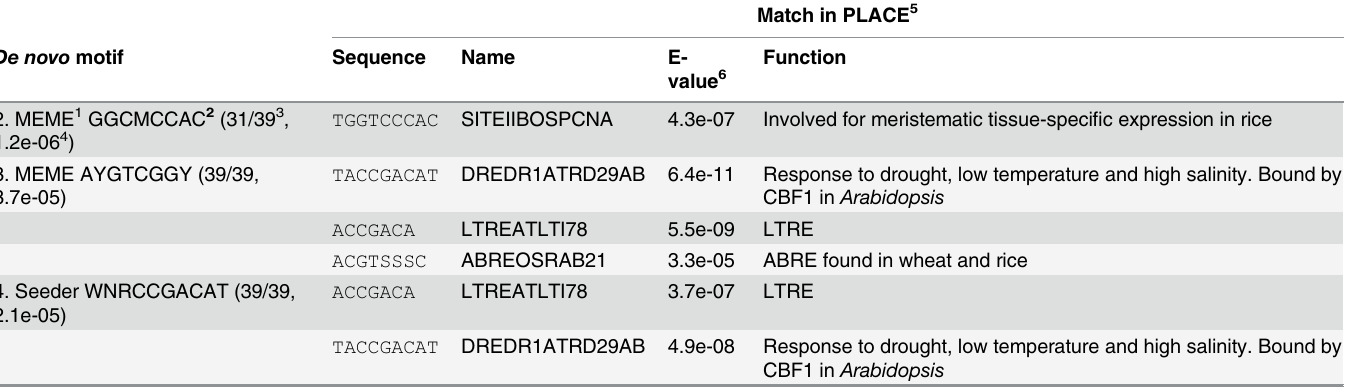
Match in PLACE 5